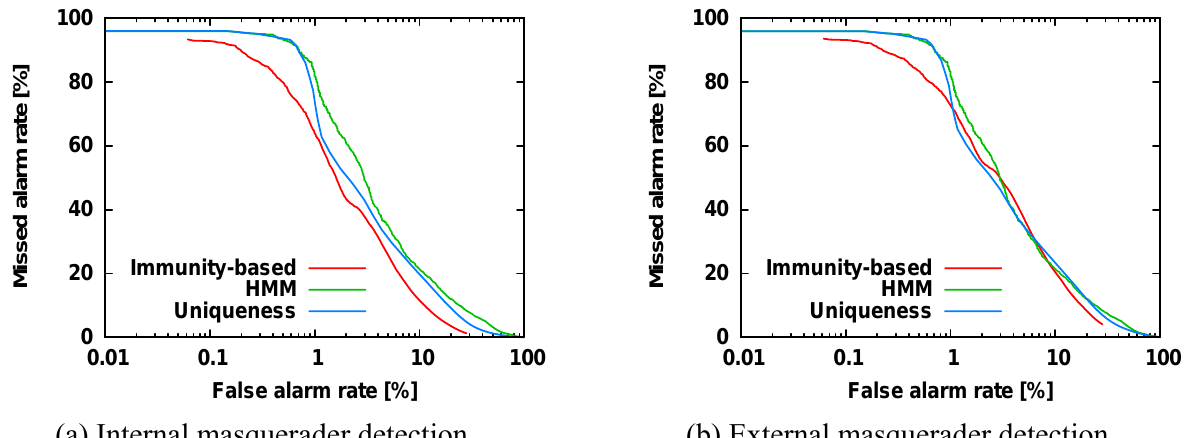
Figure 3. ROC curves for detection of internal masqueraders (a) and external masqueraders (b) using our immunity-based method, the single-sensor HMM method and the uniqueness method. The parameters are as follows: (cid:1838) (cid:3404) 100, (cid:1837) (cid:3404) 100, (cid:1840) (cid:3404) 10, (cid:2012) (cid:3404) (cid:1857) (cid:2879)(cid:2870)(cid:2868)(cid:2868) , (cid:1840) (cid:3036)(cid:3041)(cid:3047) (cid:3404) 25, (cid:1840) (cid:3032)(cid:3051)(cid:3047) (cid:3404) 25, (cid:1829) (cid:3404) 1,000. The number of internal masqueraders is 25, and the number